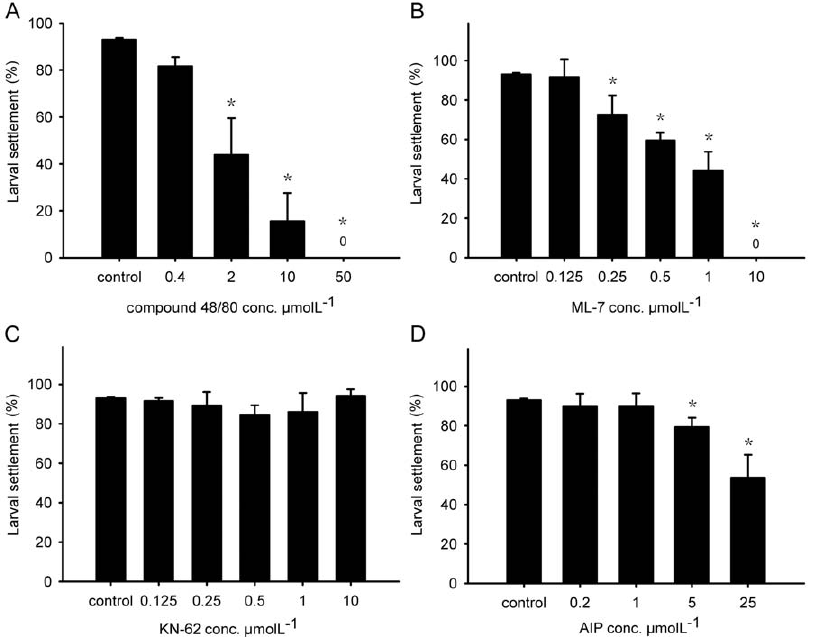
Figure 6. The effect of inhibitors on larval settlement of B.amphitrite . Inhibitor assays using (A) the CaM inhibitor compound 48/80, (B) the MLCK inhibitor ML-7, (C) the CaMKII inhibitor KN-62, and (D) the CaMKII inhibitor AIP. Data presented are the means 6 SD (n=5). Asterisks (*) indicate significant differences compared with the positive control ( P , 0.05).